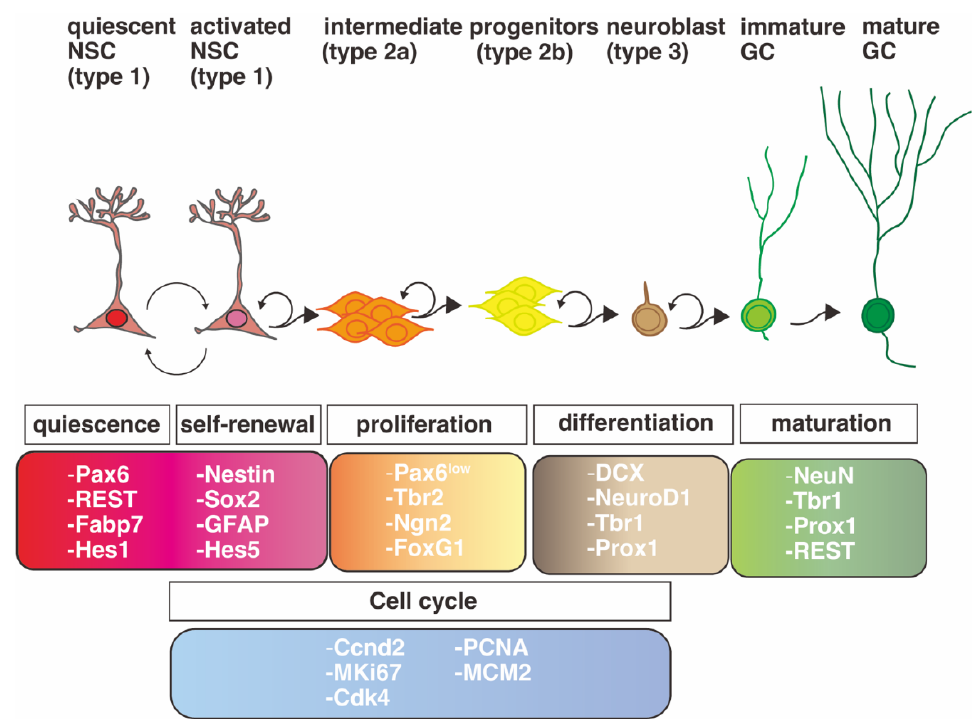
Figure 5. Linage and gene expression of NSCs in the adult hippocampal dentate gyrus. Pax6 is expressed in quiescent and active NSCs and intermediate progenitor cells (IPCs). The graphical diagram has been redrawn from [20,88,91,136–144].